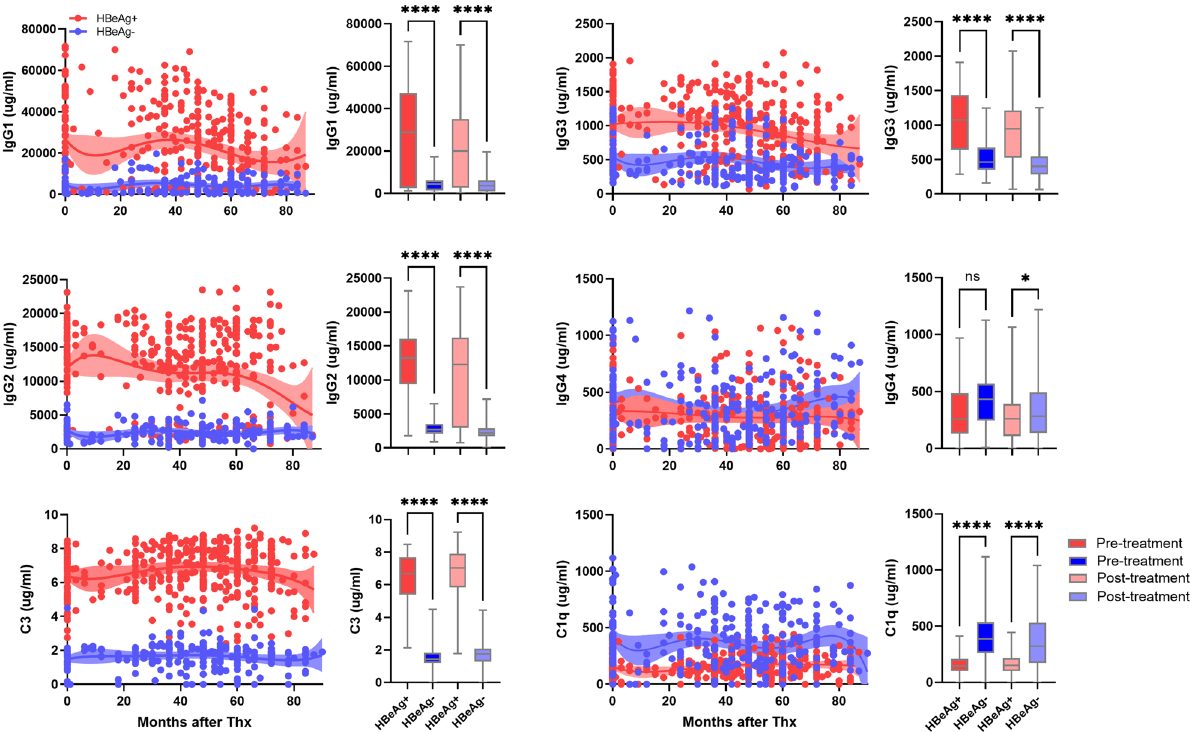
Figure 2. Serum levels of IgG subtypes and complement C3 and C1q in CHB patients with HBeAg-positive and HBeAg-negative patients. Serum levels of IgG1-4, complement C3, and C1q were measured in pretreatment and posttreatment (1–87 months) serum samples of HBeAg-positive (n = 76, red dots) and HBeAg-negative patients (n = 50, blue dots). Shaded areas indicate 95% confidence intervals around the regression lines. Bar graphs represent concentration of IgG1-4, complement C3, and C1q in pre-treatment (dark red), post-treatment (light red) of HBeAg-positive and pre-treatment (dark blue), post-treatment (light blue) of HBeAg-negative patients. *p ≤ 0.05, **p ≤ 0.01, ***p ≤ 0.001, ****p ≤